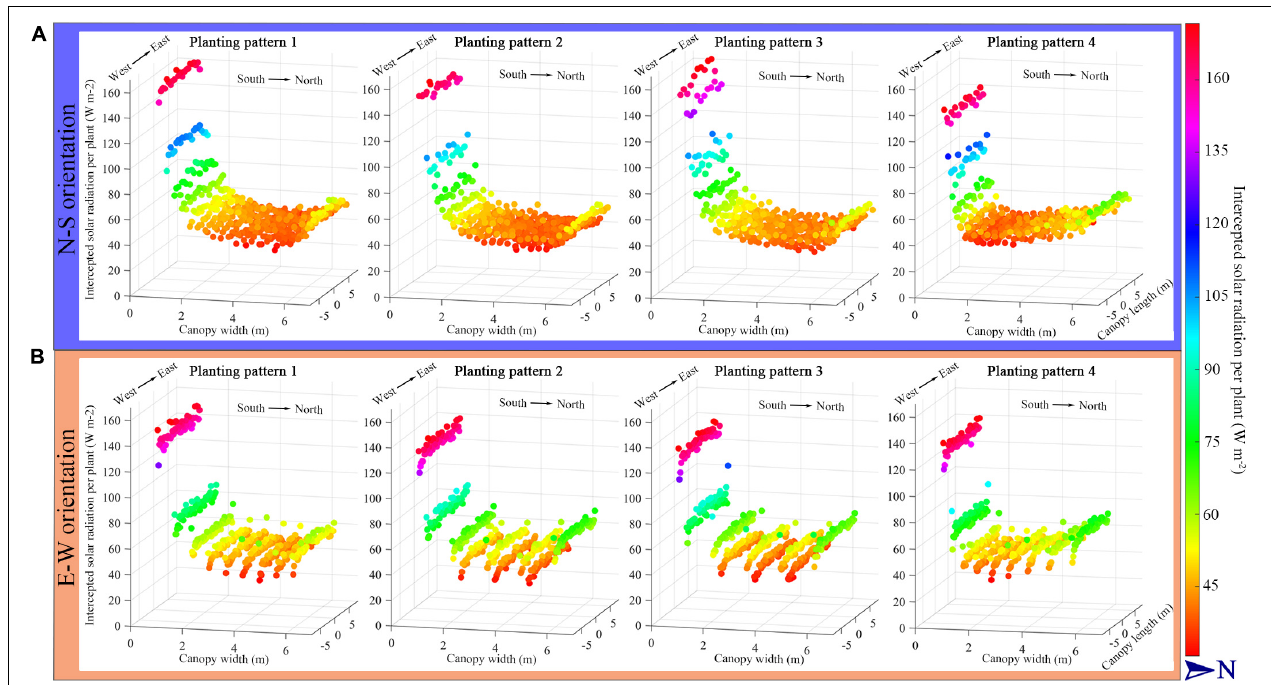
FIGURE 5 | The midday solar radiation interception per plant of the four planting patterns under N–S orientation (A) and E–W orientation (B) . Each sphere, height and color represents the intercepted solar radiation intensity of a whole plant as sum of all absorbed radiation form all leaves and leaflets of a plant.